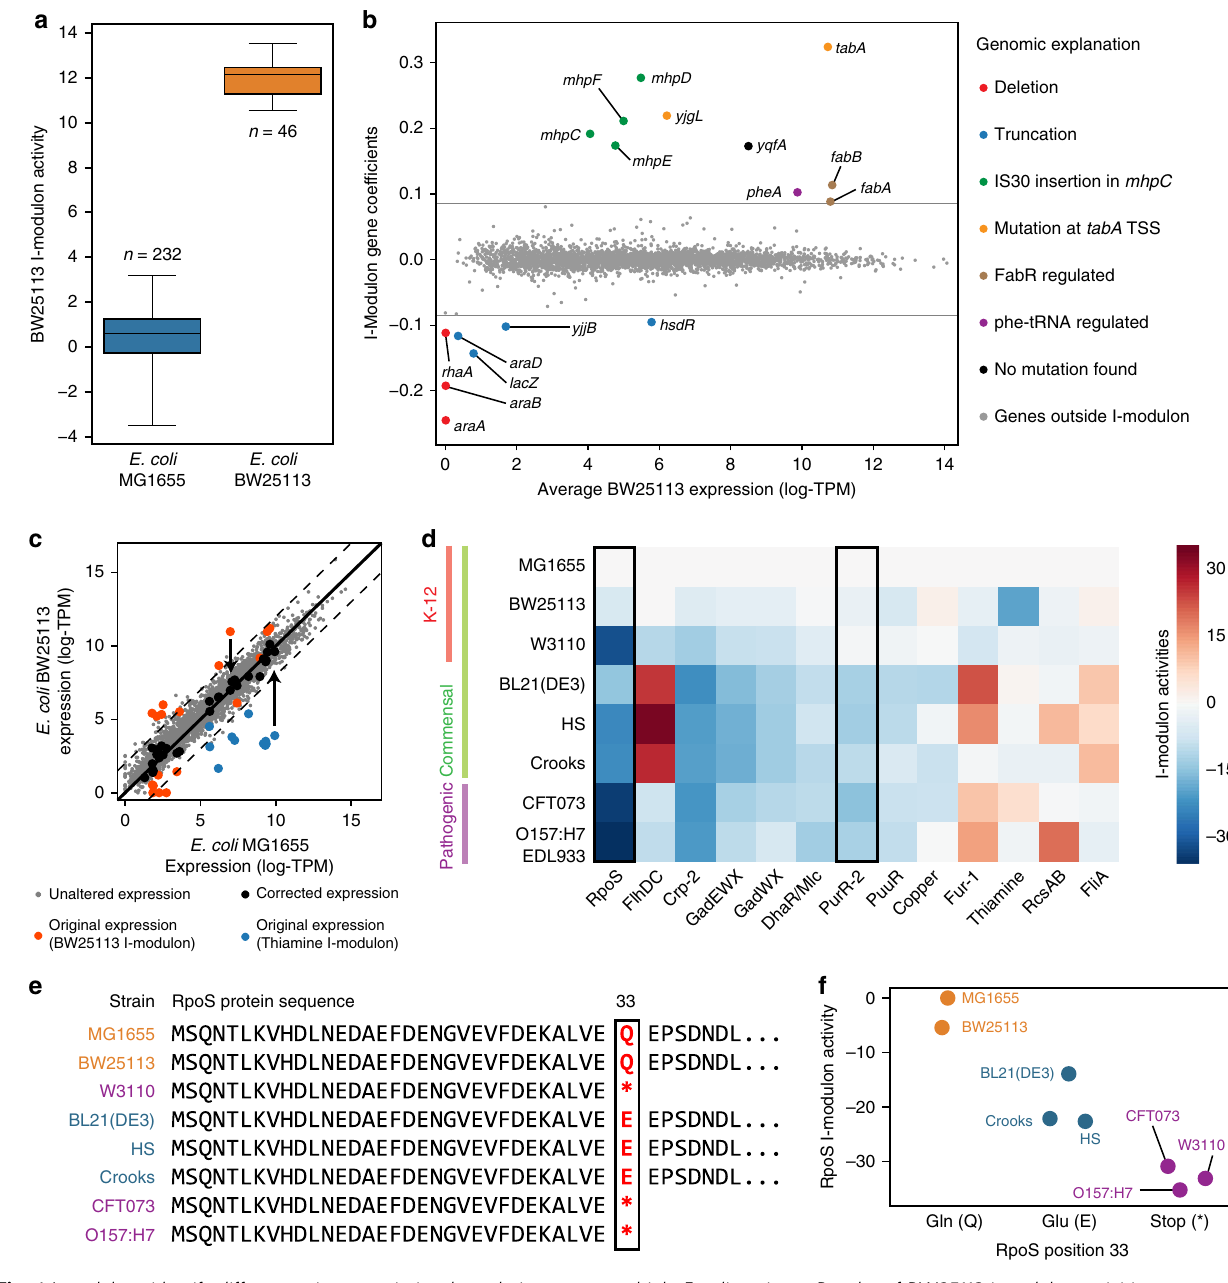
Fig. 6 I-modulons identify differences in transcriptional regulation across multiple E. coli strains. a Boxplot of BW25113 i-modulon activities separated by strain. Number of expression pro fi les in PRECISE from each strain is shown. Boxplot whiskers represent extrema of data, box bounds represent upper and lower quartiles, and center-line represents the median value. b Scatterplot of average BW25113 expression against BW25113 i-modulon activity. Deletions and truncations in the BW25113 strain account for all genes with negative coef fi cients. An insertion sequence (IS30) in the mhpC gene in the BW25113 strain corresponds to a large increase in expression of mhpCDEF , as IS30 contains a known promoter 79 . Point mutations at the predicted transcription start site (TSS) of tabA , in the FabR regulator, and in the phenylalanine tRNA pheV , account for other genes with positive coef fi cients (see Supplementary Table 7). c Subtraction of the BW25113 and Thiamine i-modulons from the E. coli BW25113 expression pro fi le accounts for the major transcriptomic deviations from E. coli MG1655 grown without thiamine. Dashed lines indicate four-fold difference in TPM. d Heatmap of estimated i- modulon activities for eight E. coli strains grown on glucose minimal media (with added thiamine and ferric chloride for BW25113). Only signi fi cantly altered regulatory i-modulon activities are shown. Boxed i-modulon activities are referred to in the main text. e Sequence alignment of the RpoS protein across the eight E. coli strains. f RpoS activities of the eight strains grouped by position 33 in the RpoS protein sequence, as detailed in panel e . Abbreviations: TSS transcription start